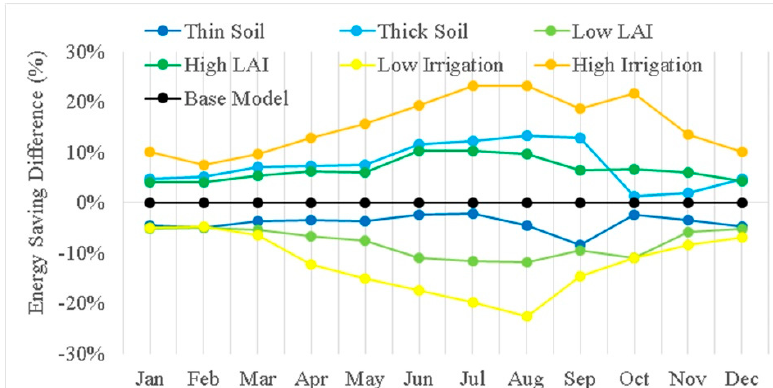
Figure 8. Differences (%) in monthly electricity savings for various green roof settings applied to the selected full-service restaurant constructed before 1980 under the A1F1 emission scenario in 2050 in Glendale, Los Angeles County, USA.